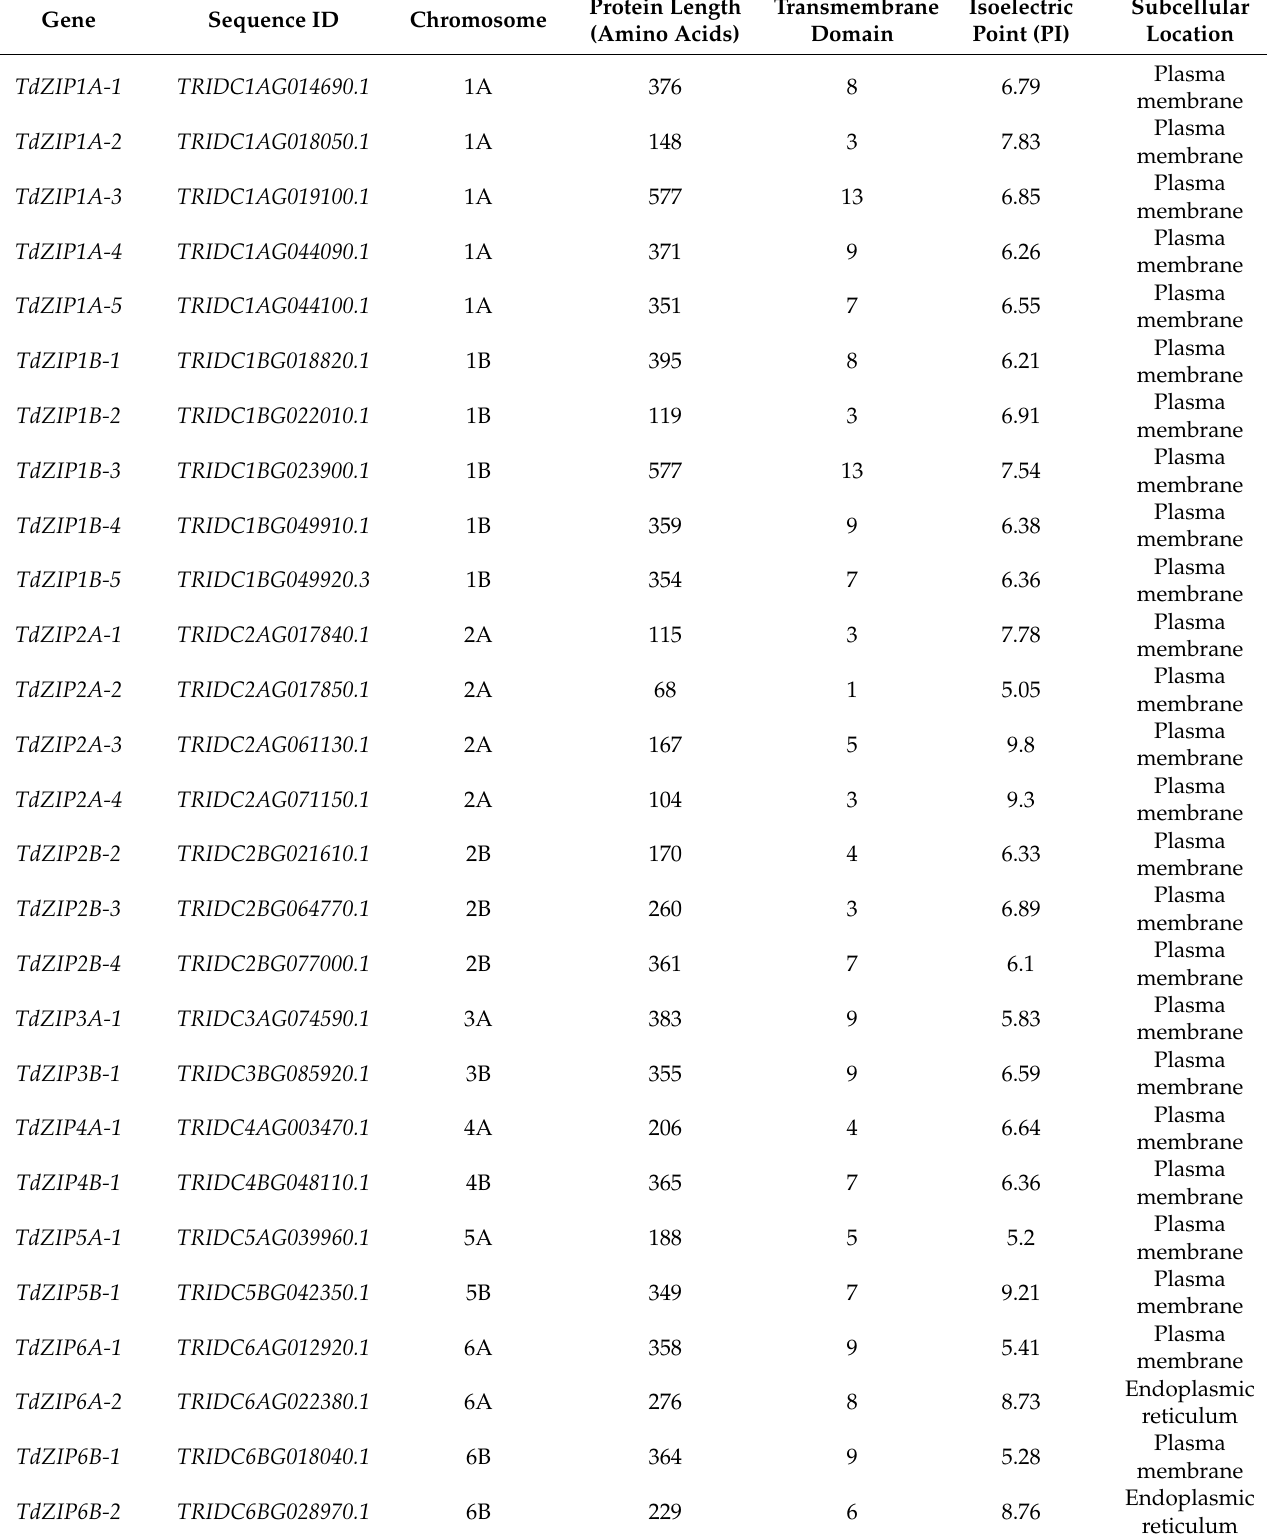
Table 1. Information and physicochemical characteristics of the TdZIP